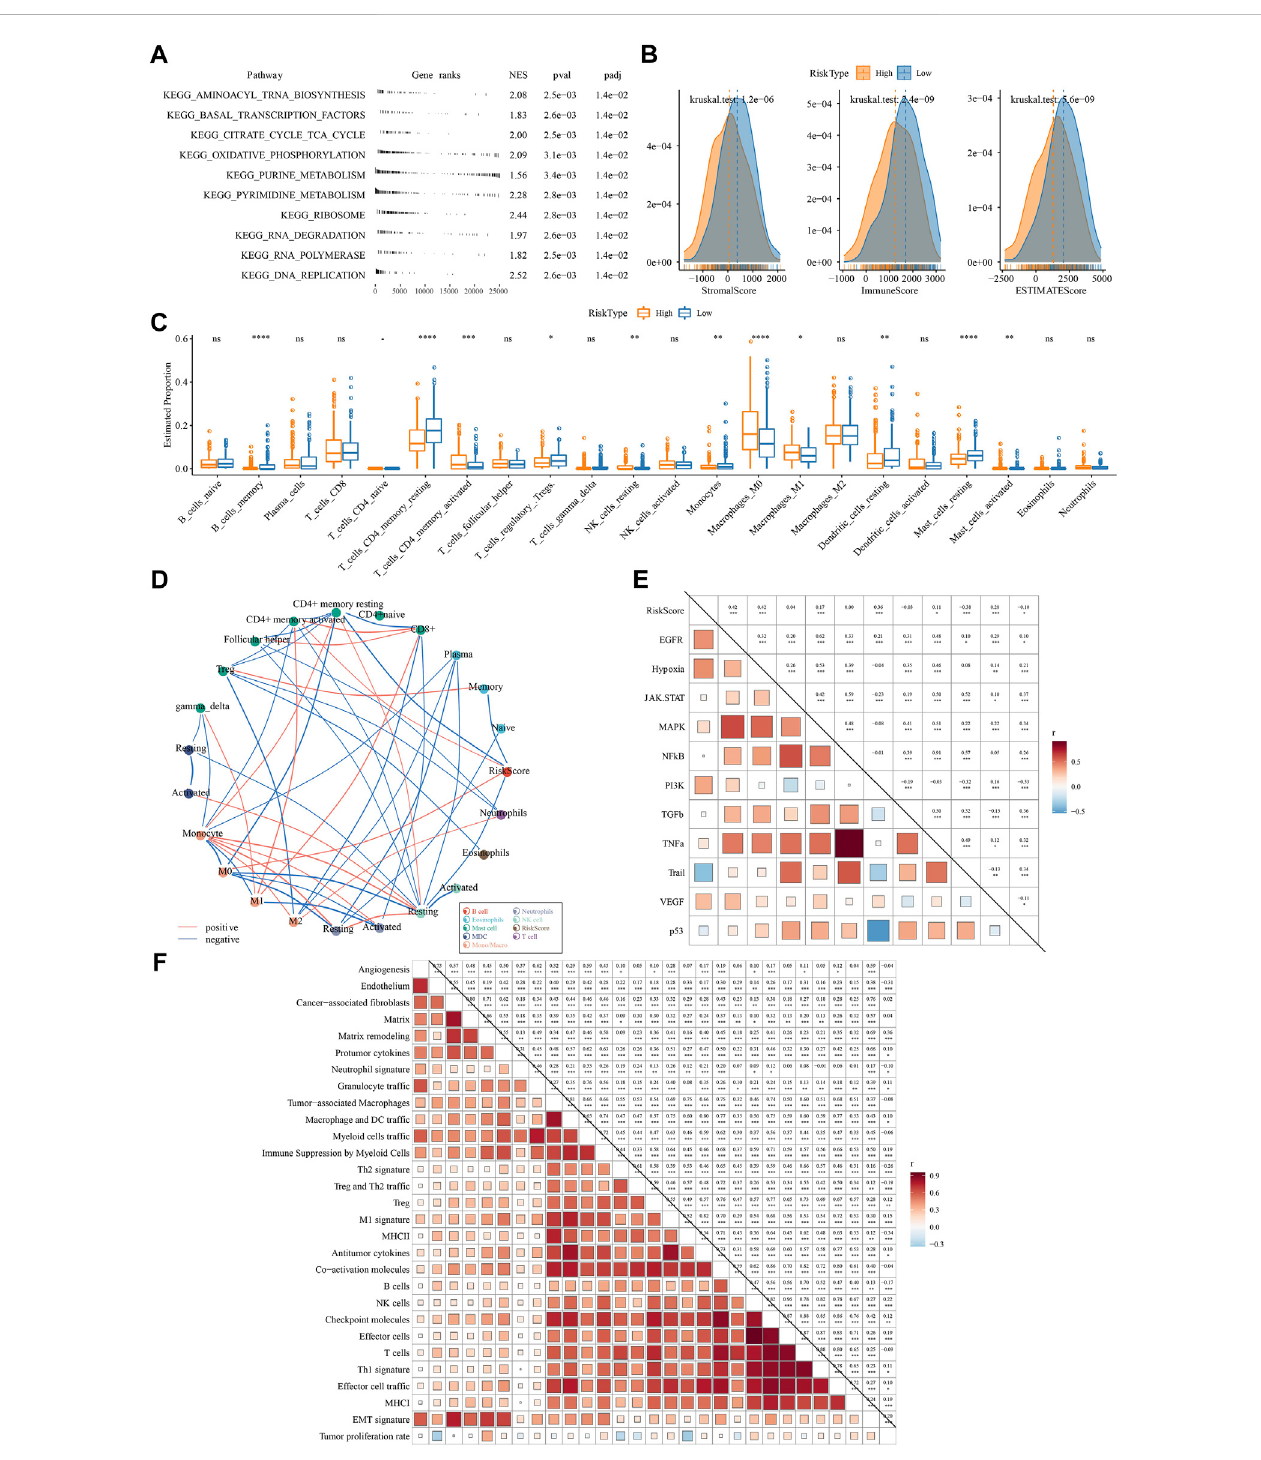
FIGURE 8 The difference of two risk groups on biological pathways and immune characteristics analyzed in TCGA dataset (A) GSEA result showed the signi fi cantly enriched KEGG pathways in high-risk group (B) The immune score, stromal score and ESTIMATE score calculated by ESTIMATE analysis (C) The estimated proportion of 22 immune-related cells analyzed by CIBERSORT (D) Correlation analysis among immune cells and risk score. Red and blue lines indicate the positive and negative correlations respectively. The thicker line indicates the stronger correlation (E) Correlation analysis among oncogenic pathways and risk score. Red and blue indicate positive and negative correlations respectively. The darker color indicates the stronger correlation. (F) the correlation analysis between risk score and 29 TME